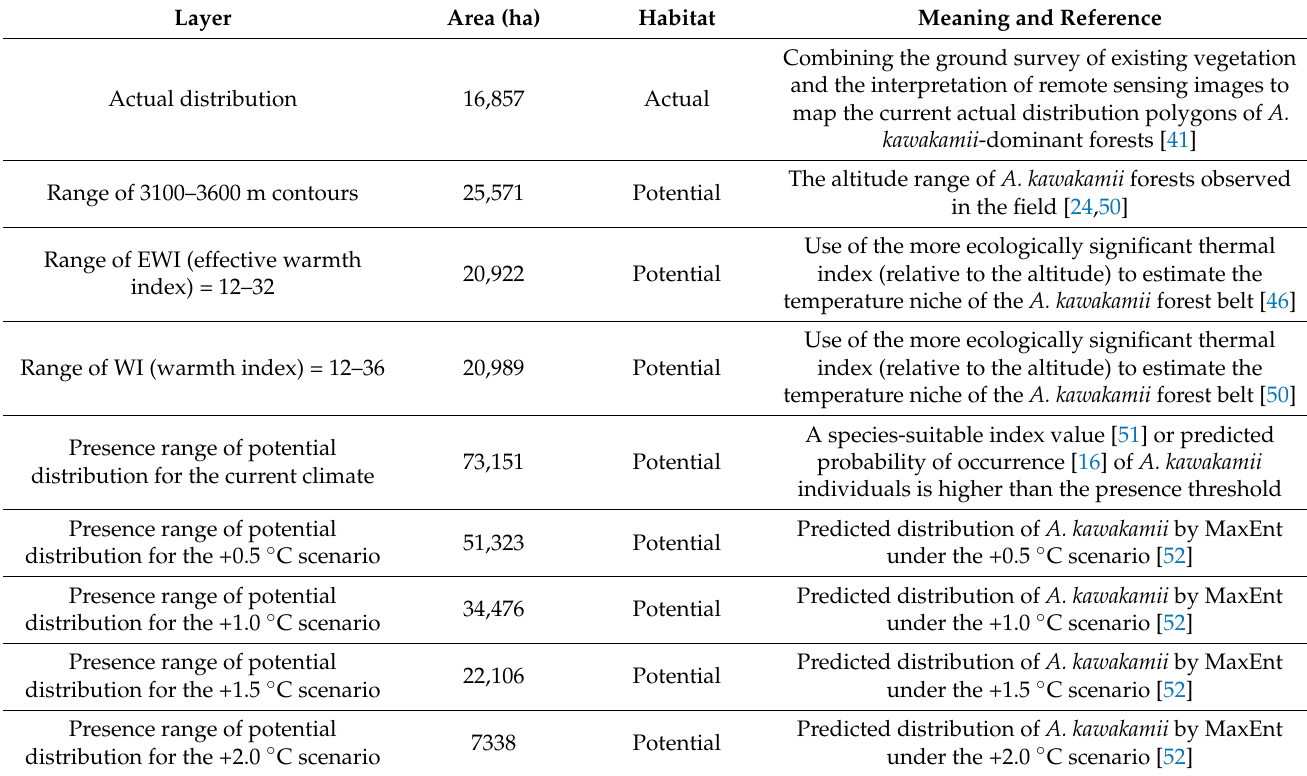
Table 3. Summary of the spatial distribution layers of A. kawakamii